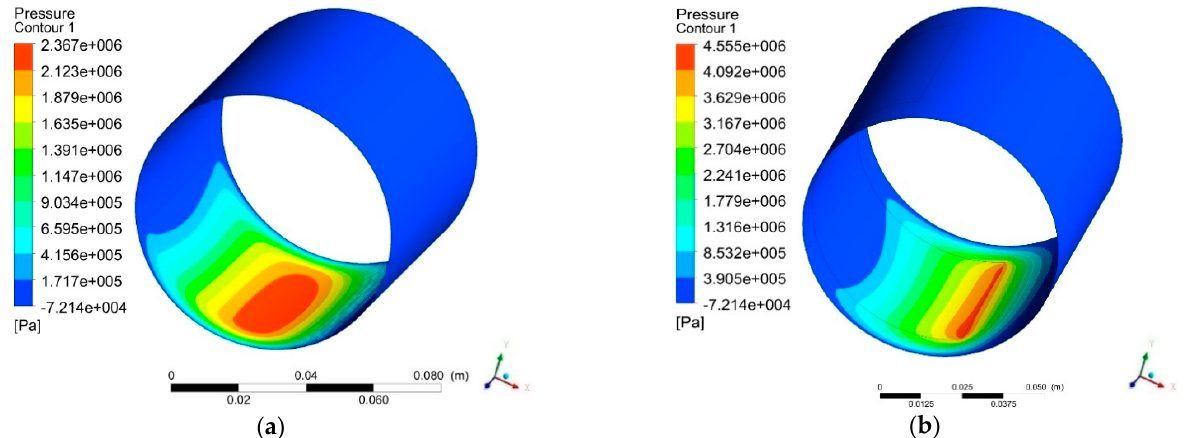
Figure 7. Comparison of the contour of hydrodynamic pressure between ( a ) the conventional (no-slip) bearing and ( b ) heterogeneous slip/no-slip bearing. All results are evaluated at n = 3000 rpm.